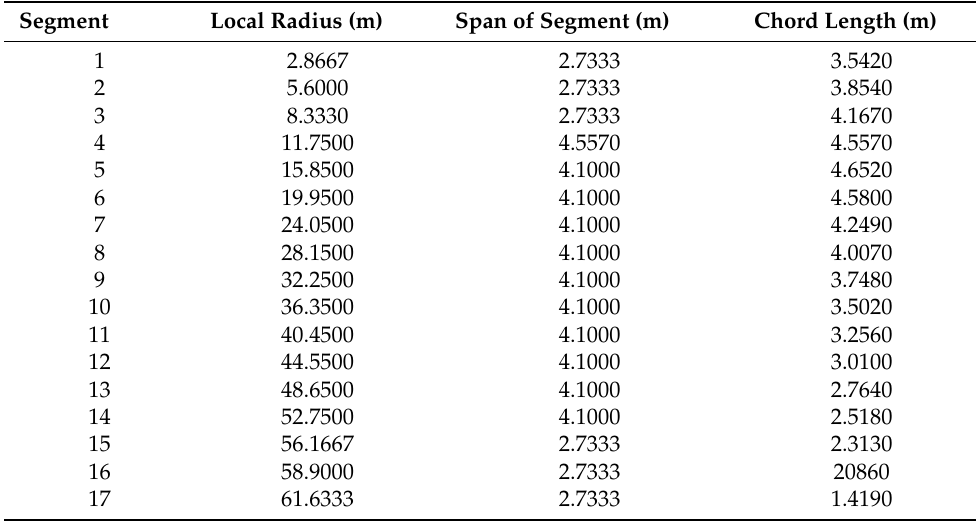
Table 1. Local data for the 5 MW NREL OWT (adopted from Reference [22]).